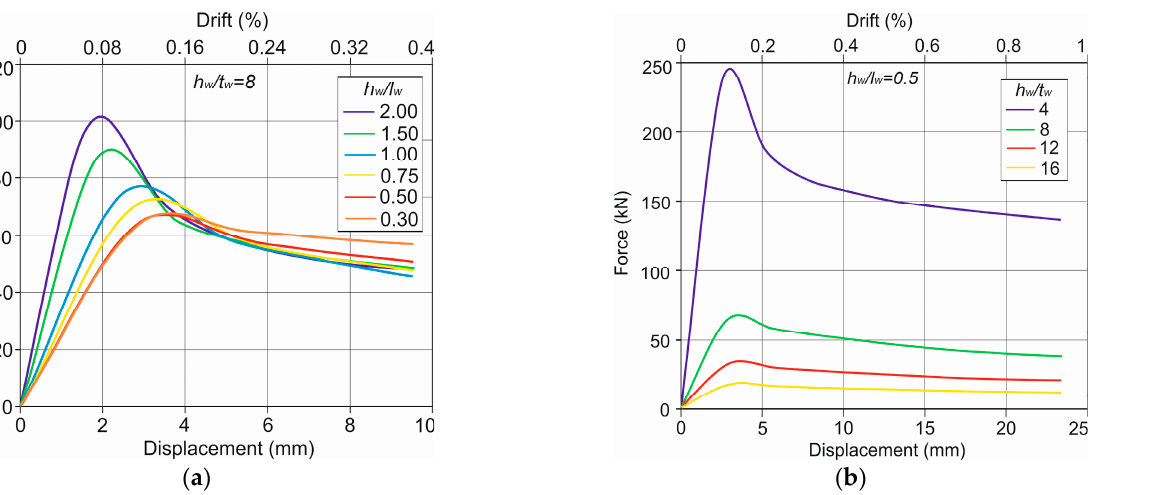
Figure 12. Influence of the ( a ) aspect ratio (for h w /t w = 8) and ( b ) slenderness ratio (for h w /l w = 0.5) on the load–drift response.